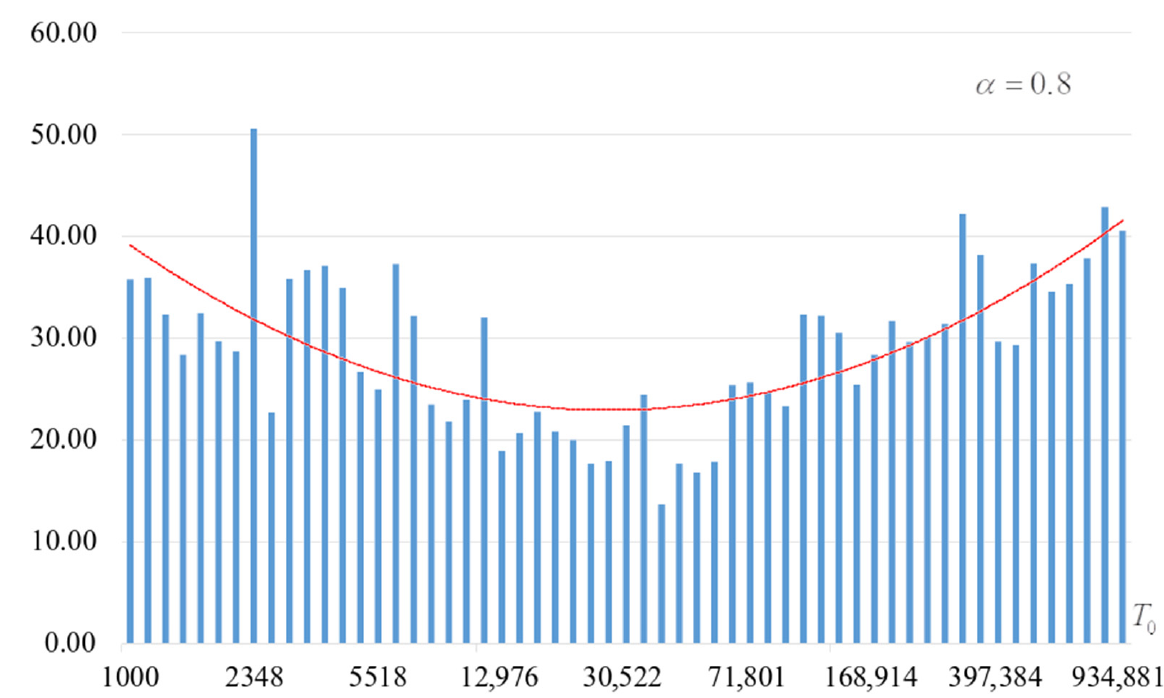
𝛼 = 0.8 . Figure 8. Average time (s) of target S-box formation at α = 0.8. Figure 8. Average time (s) of target S-box formation at Figure 8. Average time (s) of target S-box formation at 𝛼 = 0.8 .